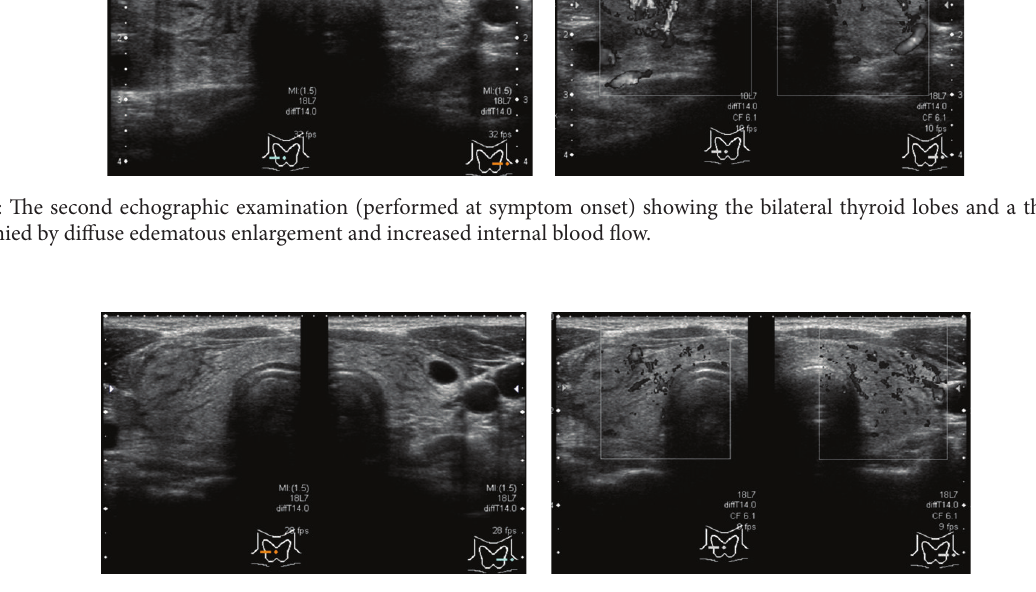
Figure 3: At 1 hour after the appearance of symptoms, the diffuse edematous thyroid enlargement and thyroid nodule had